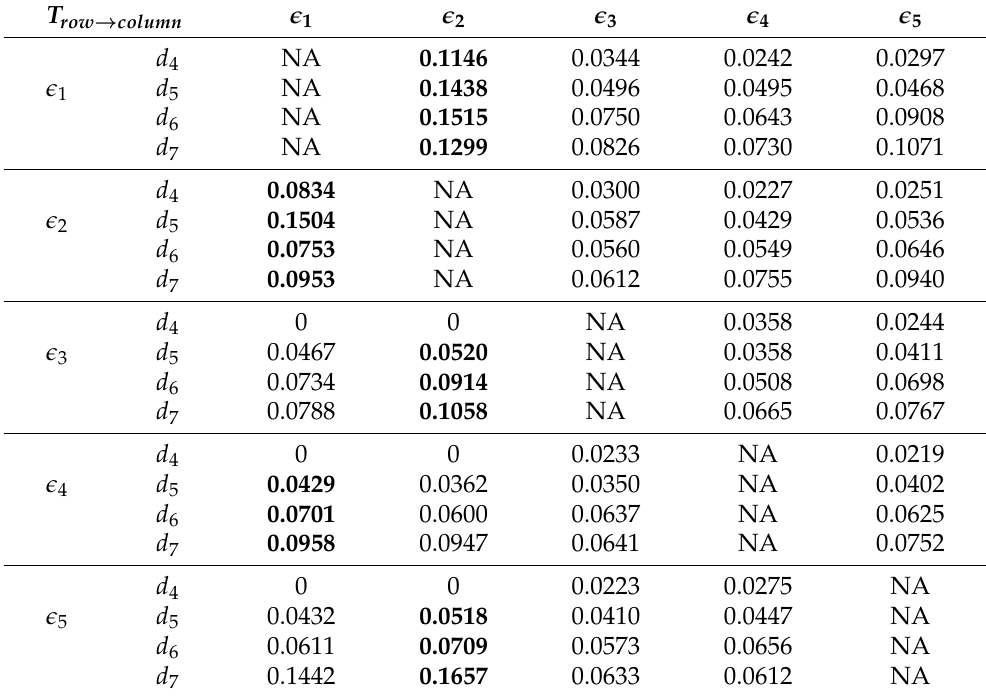
Table 3. Transfer Entropy coefficients for simulated data (Gaussian noise and Cauchy